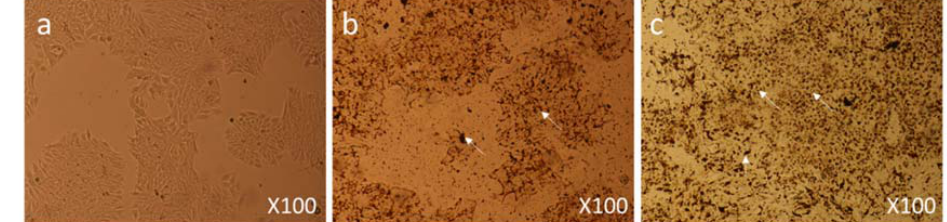
Figure 7. Cell Morphology: The MCF ‐ 7 cells showing morphology ( a ) Control (nontreated), ( b ) treated with FMSP ‐ nanoparticles (12.5 μ g/mL) for 6 h showing high level of cell death (arrows), ( c ) treated with FMSP ‐ nanoparticles (12.5 μ g/mL) for 24 h showing drastic increase in the cell death (arrows) after 24 h of post ‐ FMSP ‐ nanoparticle treatment. 100× magnification.